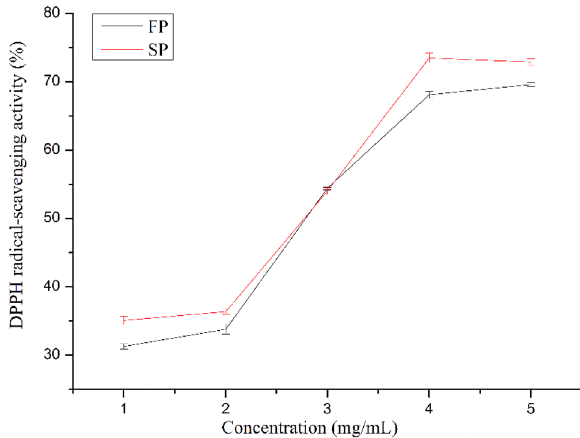
Figure 6. Effects of pectin on DPPH radical-scavenging activity.